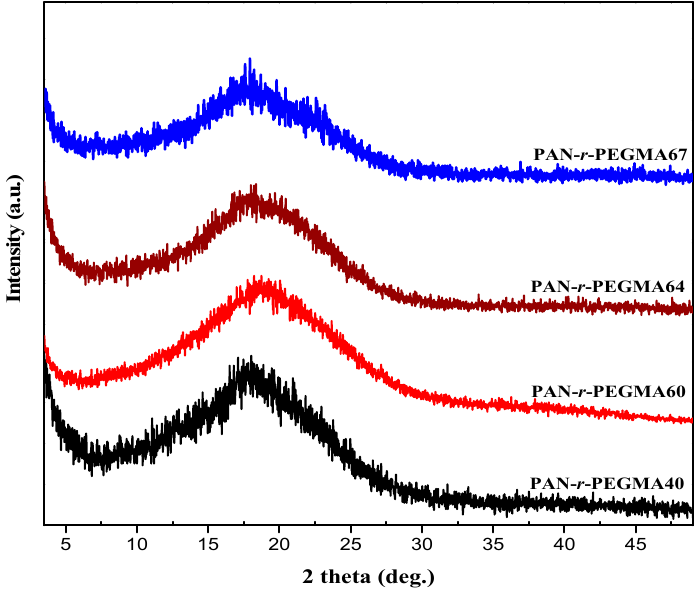
Figure 5. The WXRD patterns for PAN- r -PEGMA copolymers.